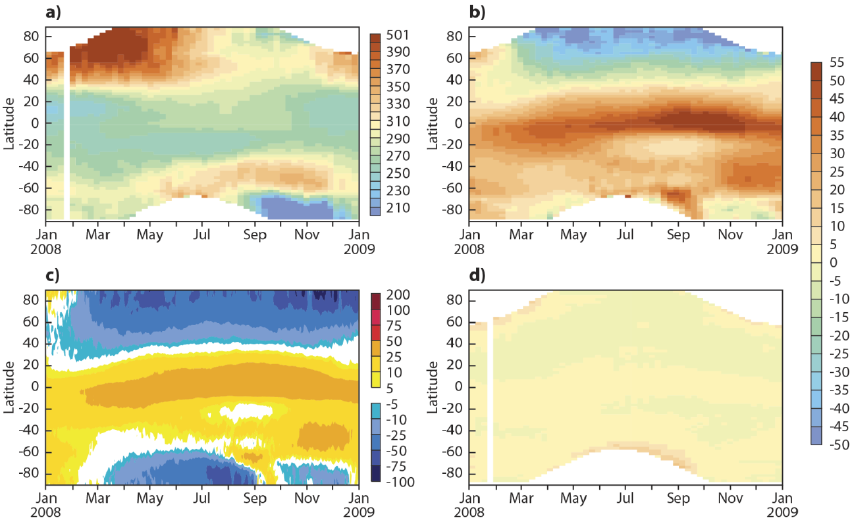
Figure 10. Time series of (a) zonal mean TCO3 in DU from OMI, zonal mean TCO3 analysis departures in % of (b) CIFS-CTRL and (d) CIFS-AN, and (c) of the zonal mean relative difference of CIFS-AN minus CIFS-CTRL. In (a) red indicates higher values of the field, blue lower values. In (b) – (d) red indicates positive values, blue negative